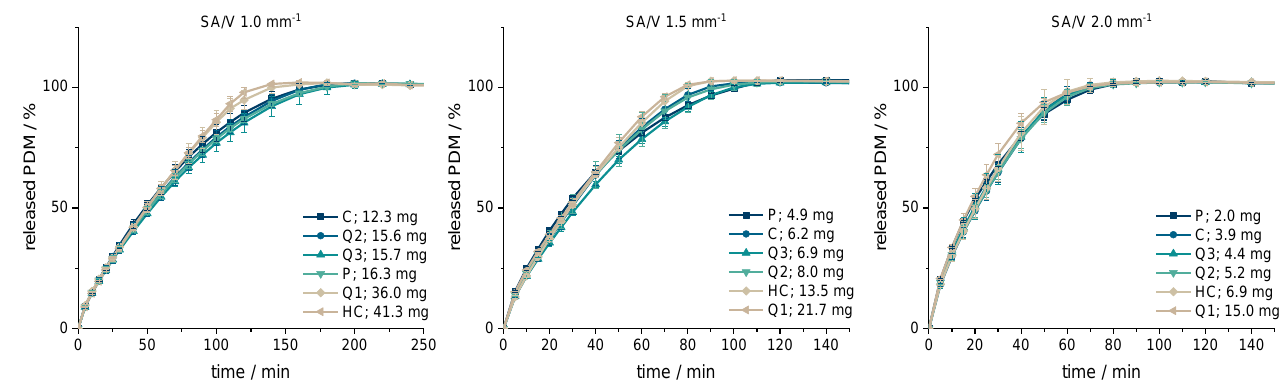
Figure 2. PDM-release curves of the geometries printed with SA/V ratios of 1, 1.5, 2 mm − 1 ( n = 6; x ± s). The smaller the SA/V ratio was, the longer it took until 100% of the API was released as the diffusion pathways are longer and vice versa. The geometries with a SA/V ratio of 1 mm − 1 released 80% of the API in 100 min, the geometries with a SA/V ratio of 1.5 mm −1 released 80% in 60 min and with a SA/V ratio of 2 mm −1 , 80% API was released in 45 min. The dosages varied by a factor of 7.5 for the SA/V ratio of 2 mm −1 , by a factor of 4.5 for the SA/V ratio of 1.5 mm −1 and by a factor of 3.4 for the ratio of 1 mm - 1 . The respective MDTs were calculated using Equation (1) and are listed in Table 3. Geometries with the same SA/V ratio have very similar MDTs that match the observed trend of the dissolution data. The MDT of geometries printed with a SA/V ratio of 1 mm −1 was 61 ± 3 min, with a SA/V ratio of 1.5 mm −1 35 ± 2 min and with a SA/V ratio of 2 mm −1 25 ± 1 min across all designs. The similarity of the curves was evaluated with the similarity factor (Equation (10)). The cylinder was used as a reference for each SA/V group. The f 2 - values are above 50 in each group and show that the curves are similar to each other. Table 3. Characteristics of the printed geometries including the calculated MDT of the PVA-PDM formulation. SA/V 1 mm − 1 Form